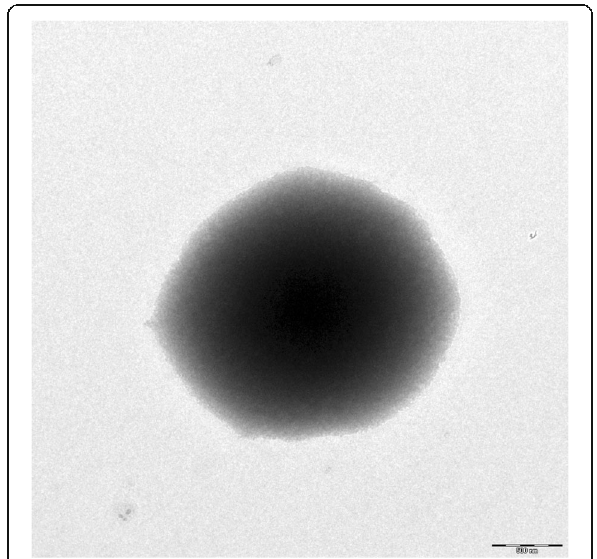
Fig. 2 Transmission electron micrograph of Arthrobacter alpinus strain R3.8. The image was taken under a scanning transmission electron microscope (STEM, LIBRA 120; Carl Zeiss AG, Germany) at an operation voltage of 80 kV. The scale bar represents 500